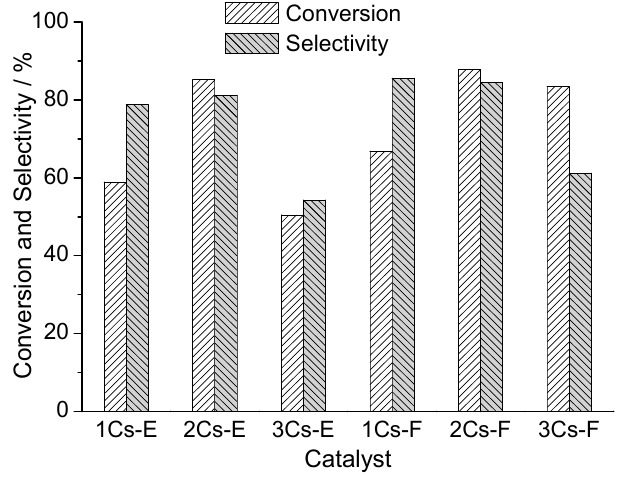
Figure 7. Catalytic performances of the catalysts.